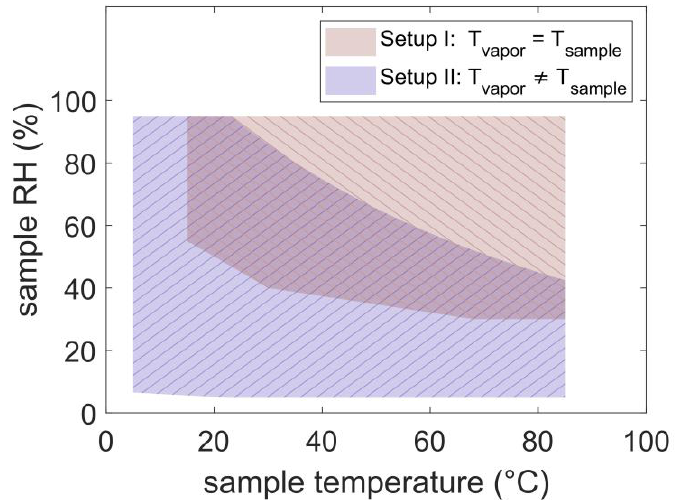
Figure 1. RH /temperature parameter space accessible with setup I (red area) and setup II (blue area). The parameter space for setup II was calculated considering T vapor = 23 °C.